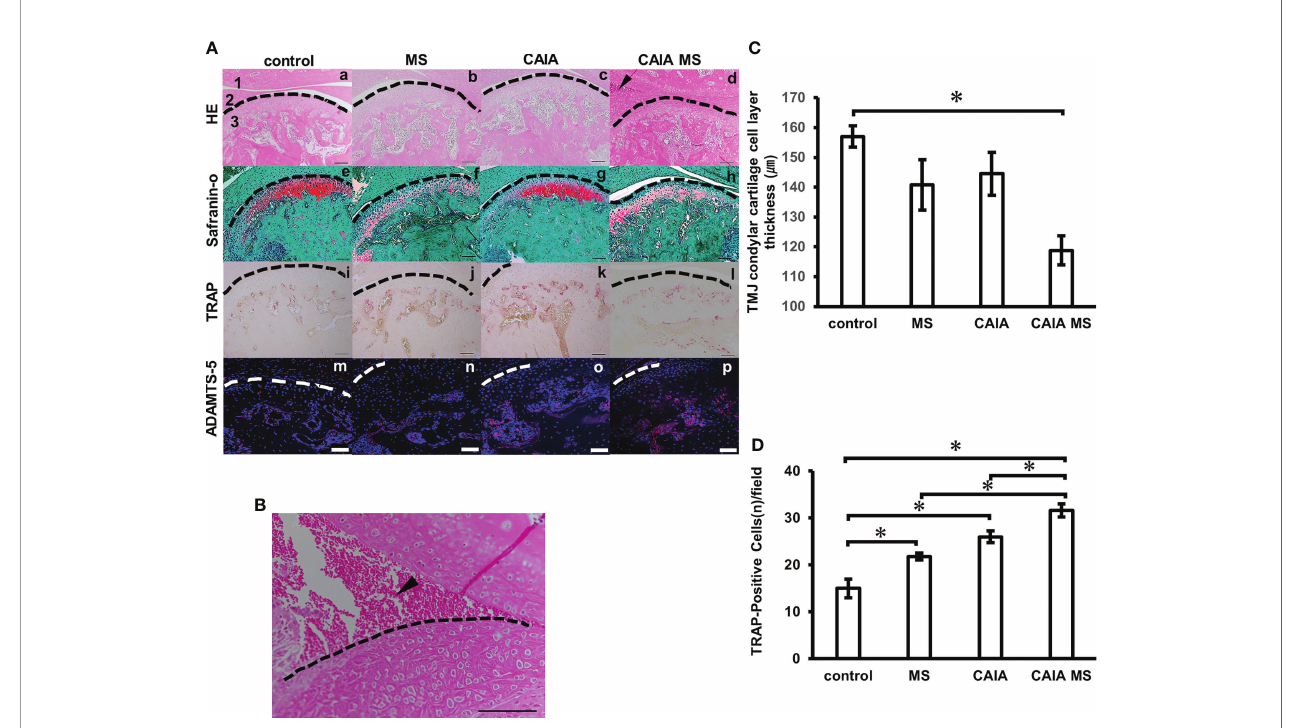
FIGURE 4 | Histological evaluation of mandibular condyle morphology. (A) (a – d) Representative hematoxylin and eosin staining with histological examination performed in each experimental group. Arrow indicates areas of in fl ammatory cell accumulation (1: mandibular fossa, 2: articular disc, 3: mandibular condyle). No major bone loss or other changes were observed. (e – h) Representative Safranin O staining. The Safranin O staining property is reduced by the addition of mechanical stress. (i – l) Representative TRAP staining. (m – p) Expression of ADAMTS-5 in the mandibular condyle (scale bar: 100 m m; red: ADAMTS-5, blue: cell nuclei). Enzyme expression in the chondrocyte layer was observed in all groups. (B) In fl ammatory cell accumulation fi ndings in the superior articular space of the temporomandibular joint in the CAIA MS group. Arrow indicates area of in fl ammatory cell accumulation. (scale bar: 100 m m) (C) TMJ cartilage cell layer thickness diameter assessment by HE staining. *P < 0.05. (D) Number of TRAP-positive osteoclasts. The number of cells with three or more nuclei within a fi xed measurement frame (450 m m × 900 m m) was counted. The CAIA MS group showed an average of 31.6 cells. *P <